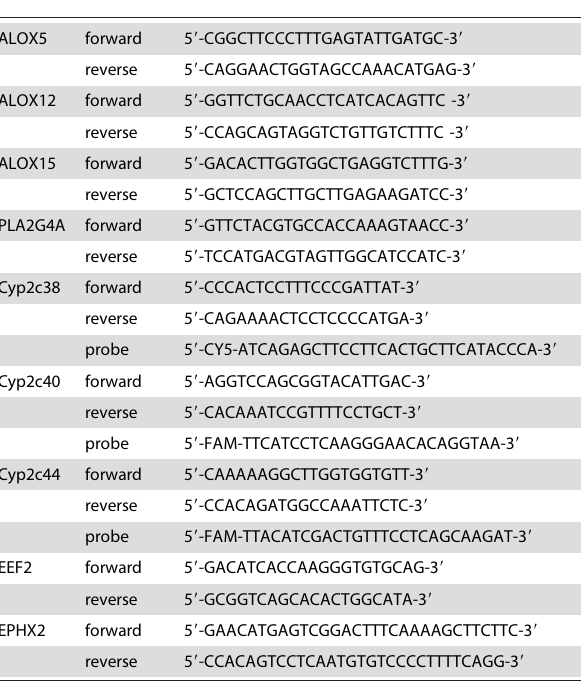
Table 1. Primers for